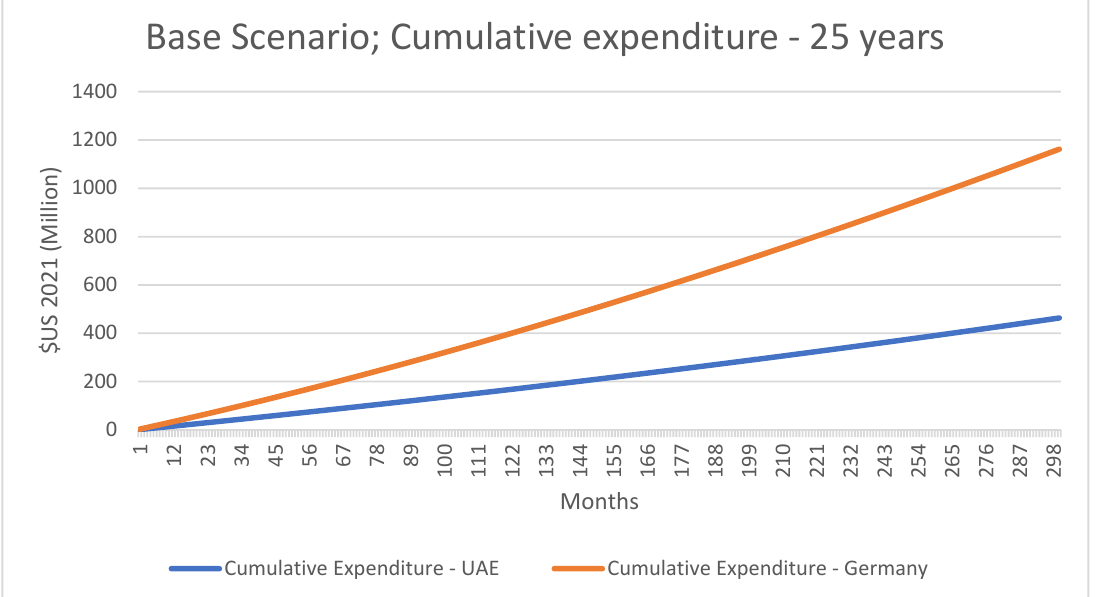
Figure 5. Cumulative emissions through electricity consumption for UAE and DE under the base scenario.